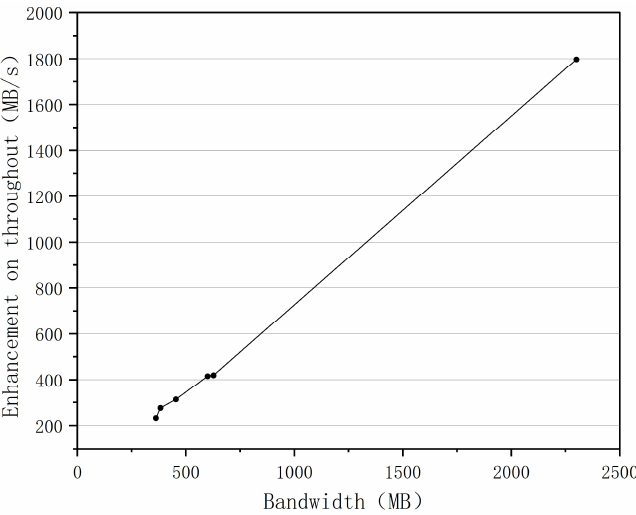
Figure 17. The throughout enhancement versus the maximum network bandwidth.